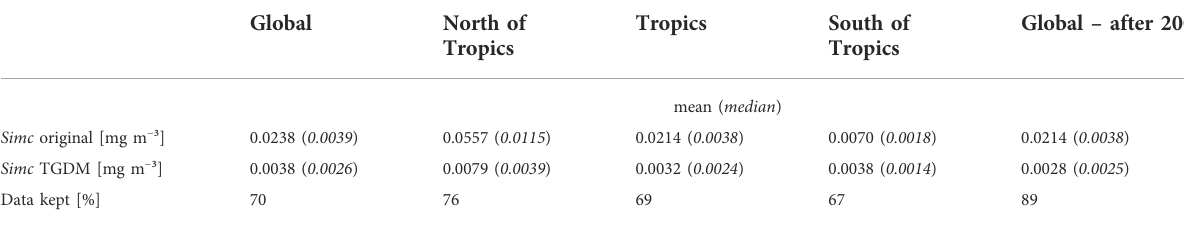
TABLE3TGDMeffectonthemagnitudeoftheinconsistencies( Simc )oftheChl- a timeseries (monthlymeanandmedian) anddatakeptcomparedto the original data set for several subsets (geographical and temporal). Global North of Tropics